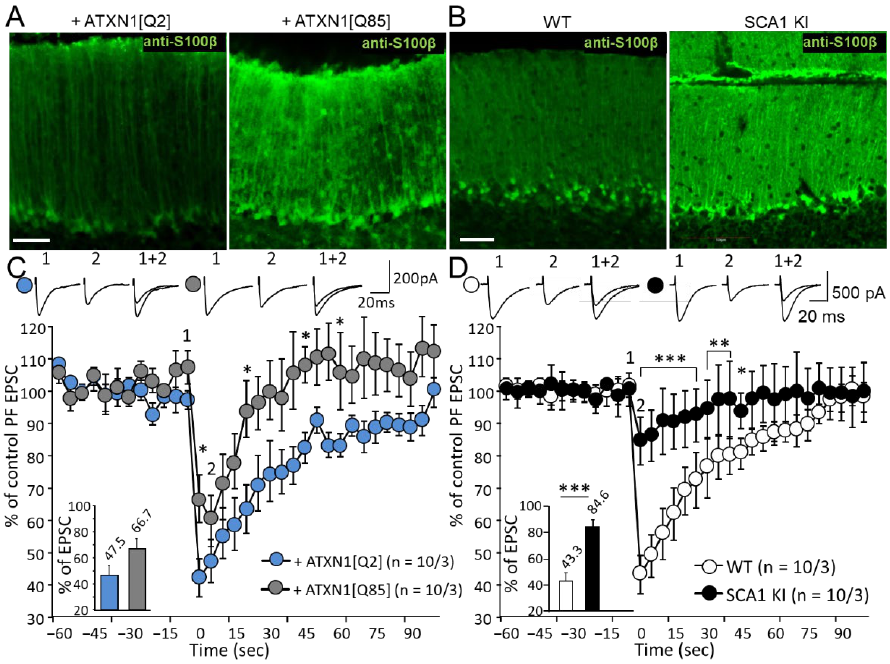
Figure 5. Reactive glia in SCA1 model mice alters depolarization-induced depression of excitation (DSE). ( A , B ) Confocal images of cerebellar cortex show the enhanced S100β expression in mice that express ATXN1[Q85] selectively in BG ( A ) and in SCA1 KI mice ( B ) Scale bar 50μm. ( C , D ) Average PF EPSC amplitudes before (1) and immediately after (2) depolarization. The amplitudes of PF EPSC were normalized to values before depolarization. Inserts show the average normalized amplitudes at time point 2. The number ( n ) of tested PCs and animals (PCs/animals) are indicated on the graphs. Asterisks indicate a statistically significant difference compared with controls (one-way ANOVA followed by Tukey’s post hoc test; * p < 0.05; ** p < 0.01; *** p < 0.001). Cells 2022 , 11 , x FOR PEER REVIEW